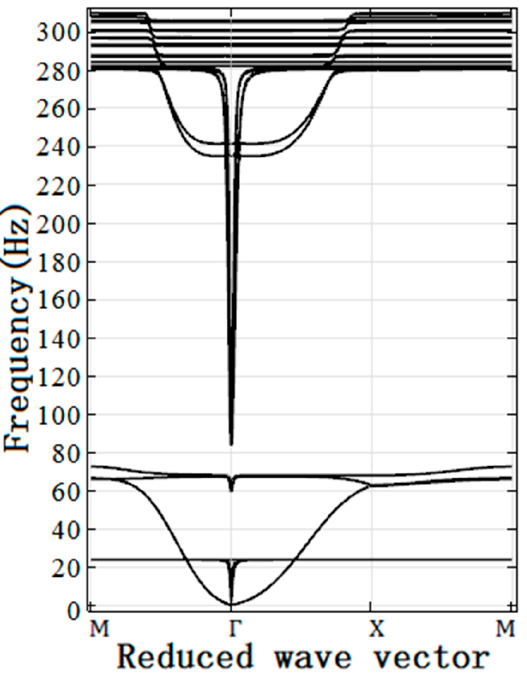
Figure 8. Band structure of LRPC DPS if the Poisson’s ratio of soft shell is 𝜇 (cid:3028) (cid:3404) 0.2 .